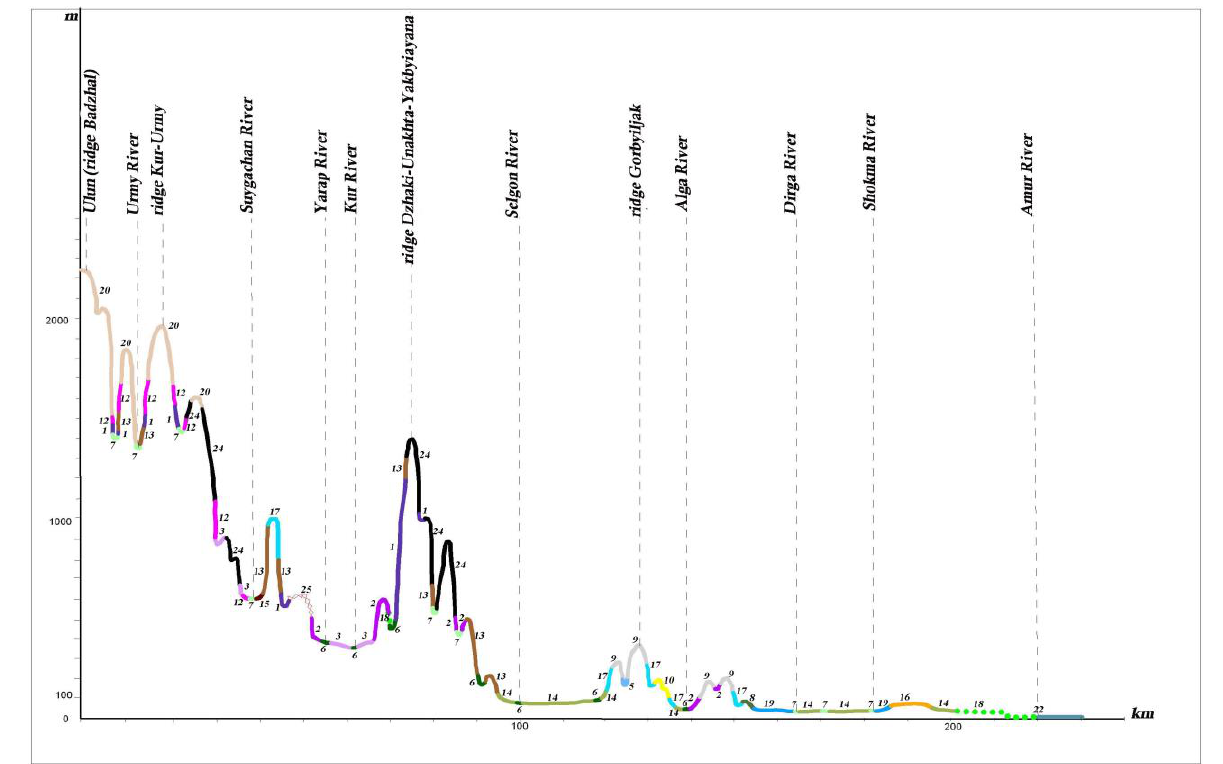
Figure 12. Profile of the plant cover from the Amur River to the mountain Ulun (I B) (see the legend in the Figure 10).